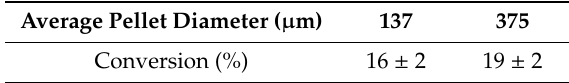
Table 4. Conversion of two aldol reaction experiments with hexane as solvent for di ff erent catalyst pellet sizes.